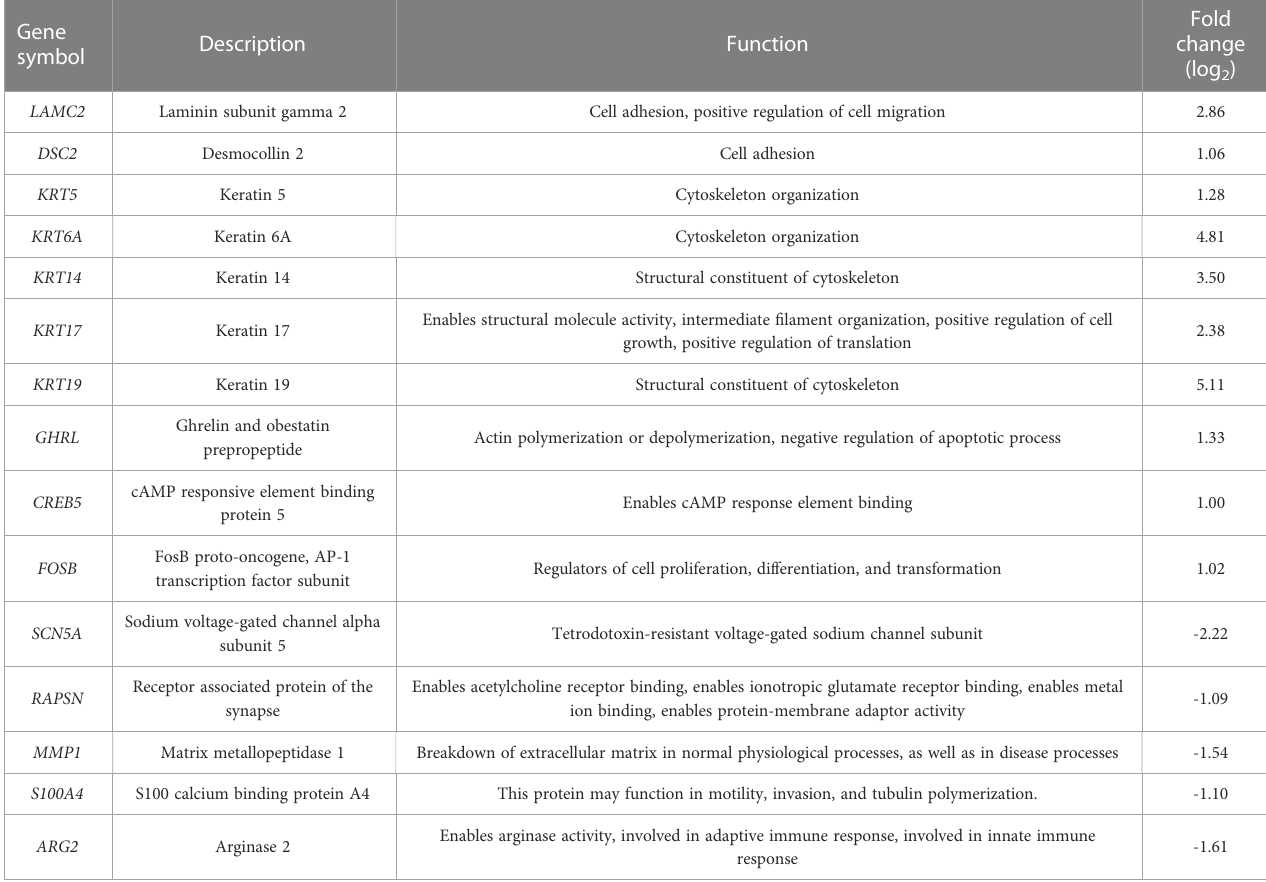
TABLE 1 15 genes that may be associated with increased granulocytes cancer-killing ef fi ciency (NA + Rg1 group vs NA group).